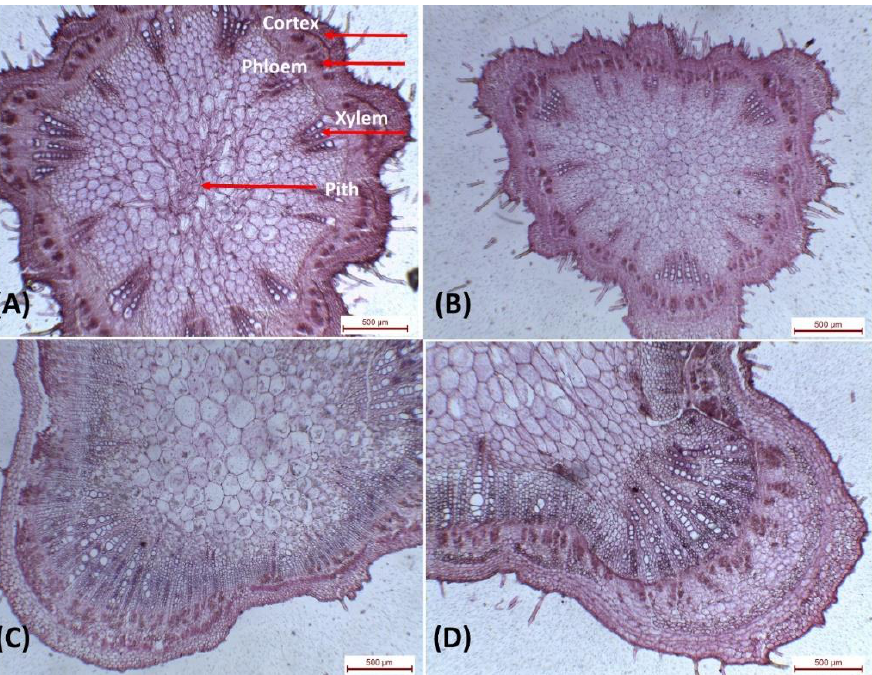
Figure 9. Transverse sections through the 4th internode of soybean stem at the age of 90 days, ( A ): Control plants (100% FC), ( B ): Control plants (50% FC), ( C ): Plants sprayed with Cu-NPs at 3 mM, and ( D ): Plants sprayed with GA-NPs at 1 mM, 100×.